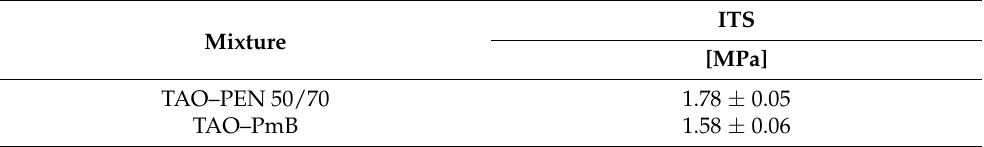
Table 5. Average ITS values of TAO–PEN 50/70 and TAO–PmB.